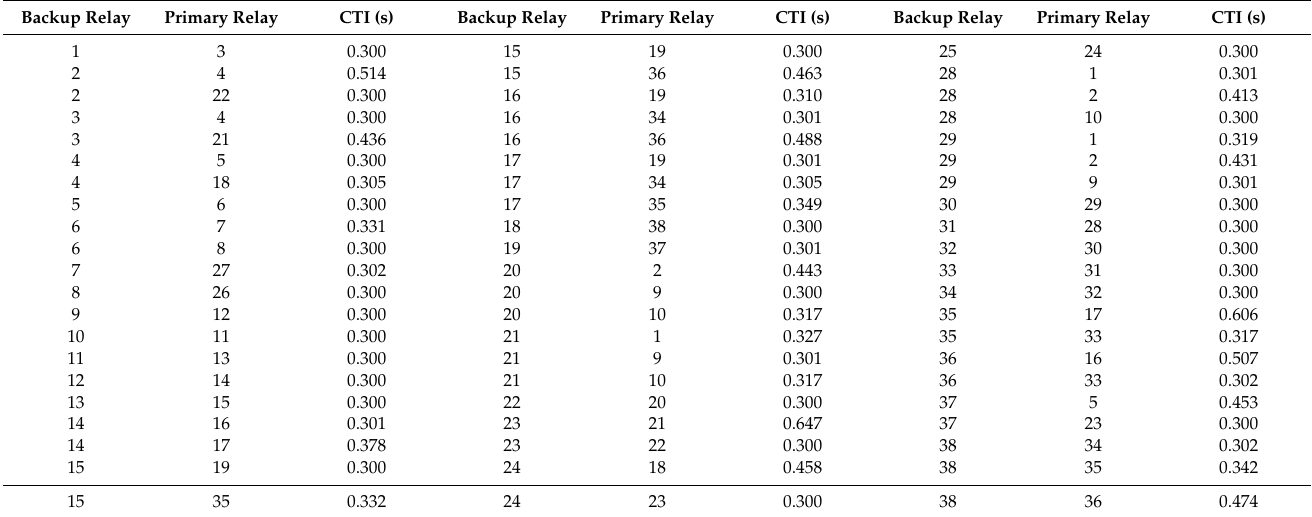
Table 11. CTI for the Meshed 30-bus Test System.